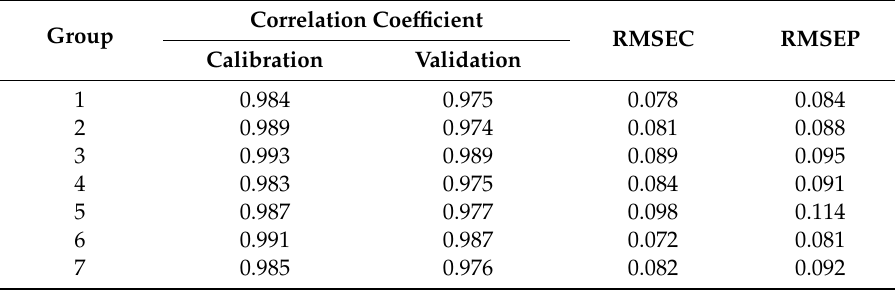
Table 4. Results of the physico-chemical analyses.